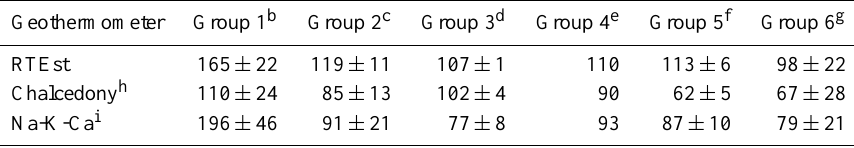
a Standard deviation for RTEst temperatures are calculated using RTEst temperatures of each group without incorporating standard error associated with estimated temperature of individual sample; b Na-Cl type water ( n = 12 );